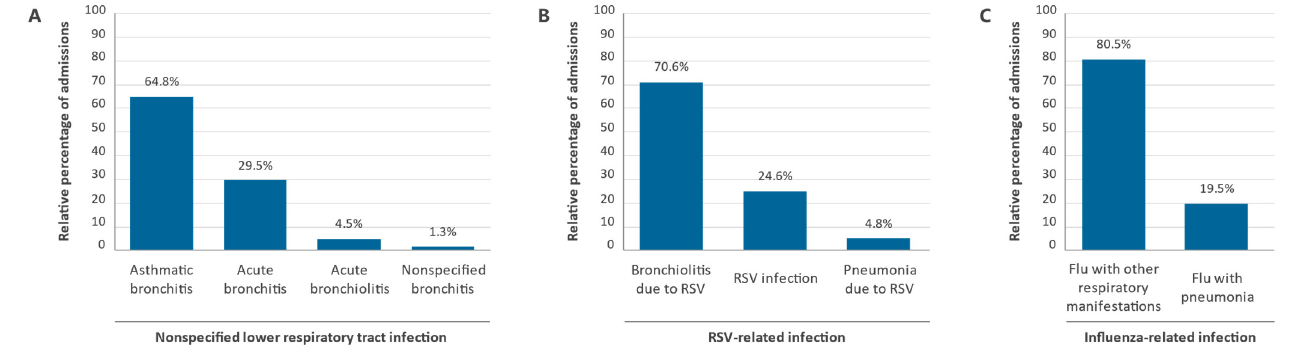
for patients in the “nonspecified lower respiratory tract infections” diagnostic group, 1.69 (95% CI 1.68–1.70) for patients in the “RSV-related infection” diagnostic group and 2.72 (95% CI 2.71–2.73) for patients in the “influenza- related infections” diagnostic group. N (%)—number of patients (% of patients with respect to the total number of patients in the group); RSV—respiratory syncytial virus; yr—years.